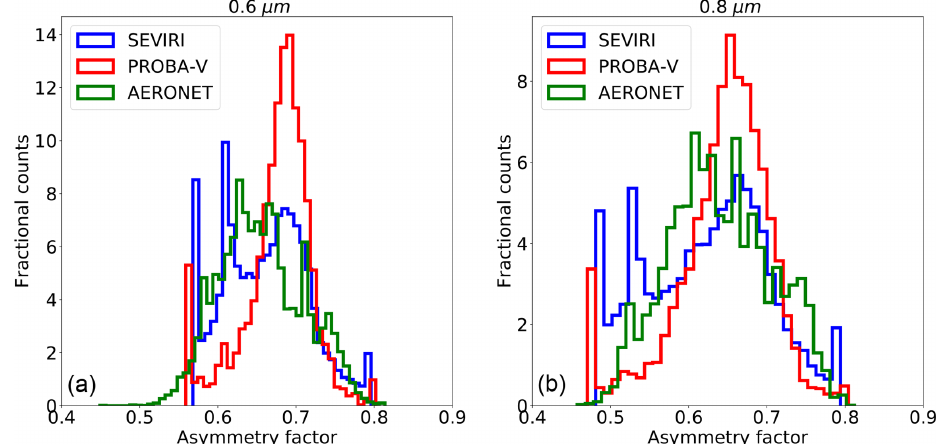
Figure 17. Same as Figure 16 but for the asymmetry